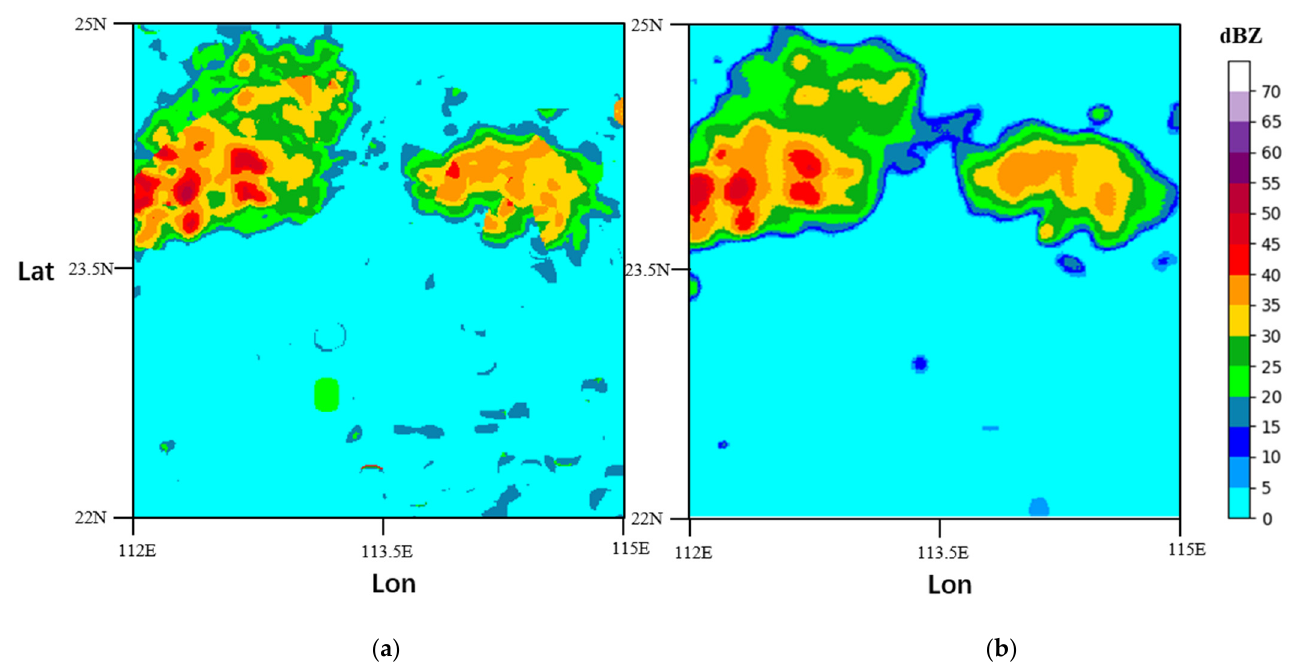
Figure 5. Predicted radar echo image with the lead time: 12 min ( a ) ground truth; ( b ) with the STPNet method. The radar echo images are of Southern China (around Guangzhou City) at 31 March 2019.